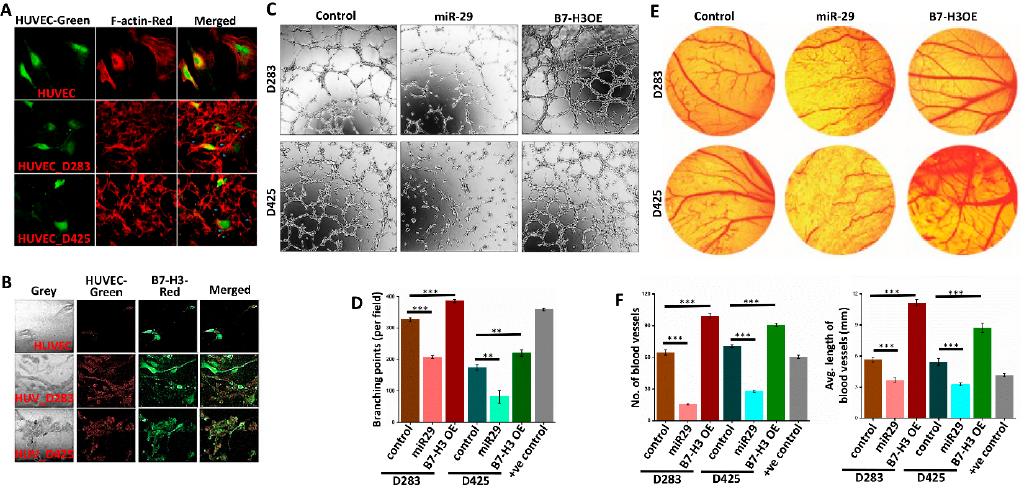
Figure 3. B7-H3 promotes and miR-29 inhibits angiogenesis of HUVEC cells. ( A ) Co-culture of HUVEC cells alone ( top ), with D283 cells ( middle ), or with D425 cells ( bottom ). HUVEC cells were stained with calcein AM ( green ). F-actin ( red ) staining shows actin filament networks. ( B ) Co-culture of HUVEC cells alone ( top ), with D283 cells ( middle ), or with D425 cells ( bottom ) showing B7-H3